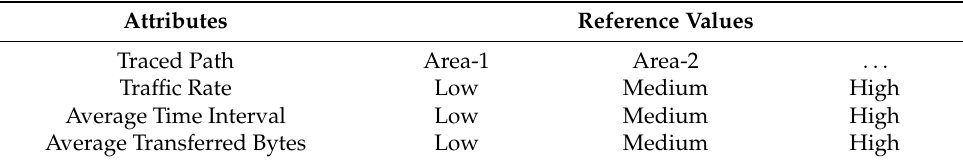
Table 1. Reference